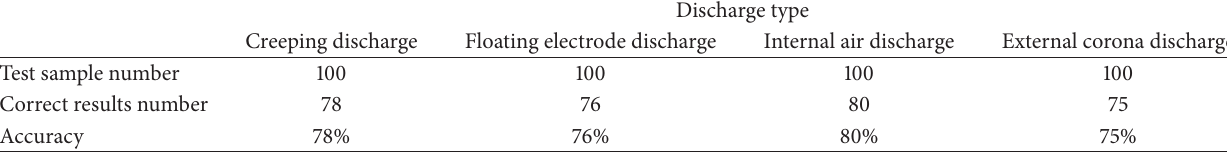
Table 9: Results of BP neural networks.